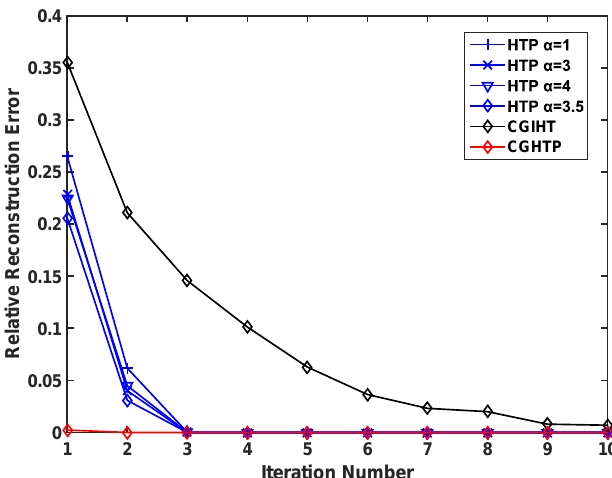
Figure 6. Relative reconstruction error vs. iteration number, ( s = 10, M = 120).